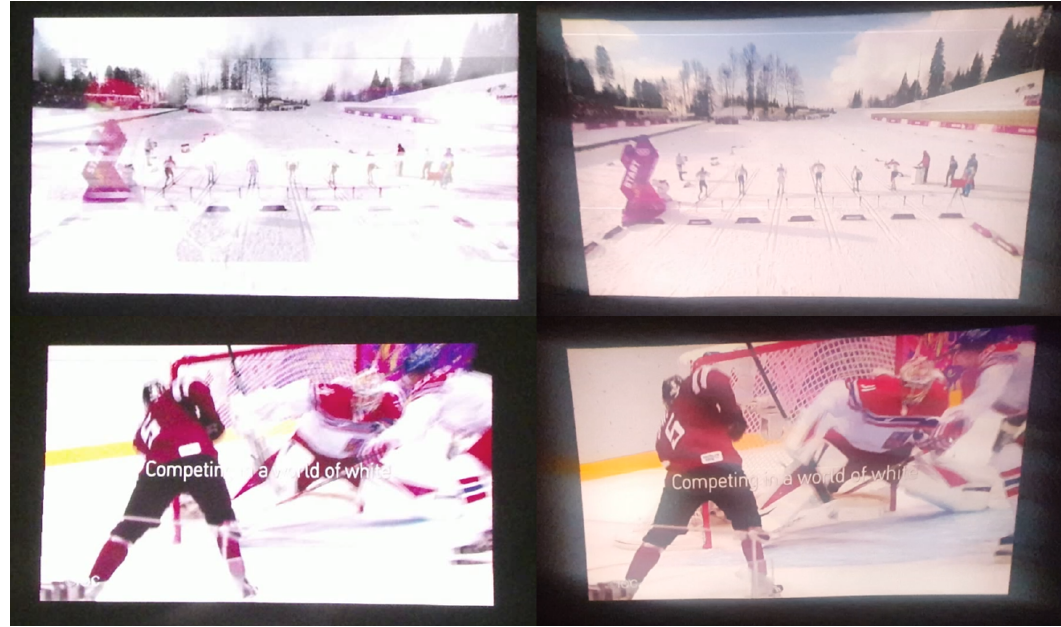
Figure 12. DIW results from dynamic non-planar surfaces manually generated by a human. The left and right columns depict the result obtained with the proposed method and the output of a conventional projector,